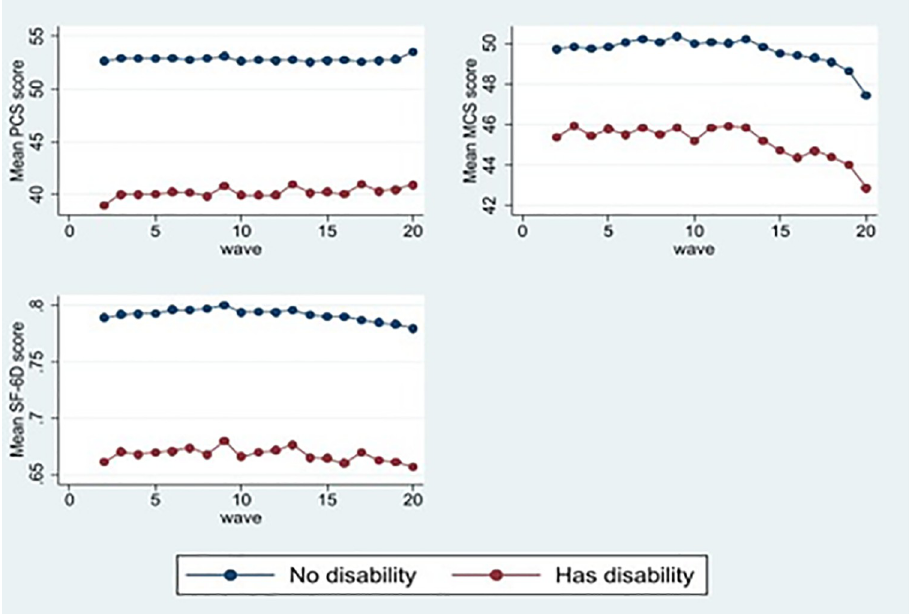
Fig 2. Mean SF-36 component summary scores and SF-6D utility score by disability status, waves 2002–2020.